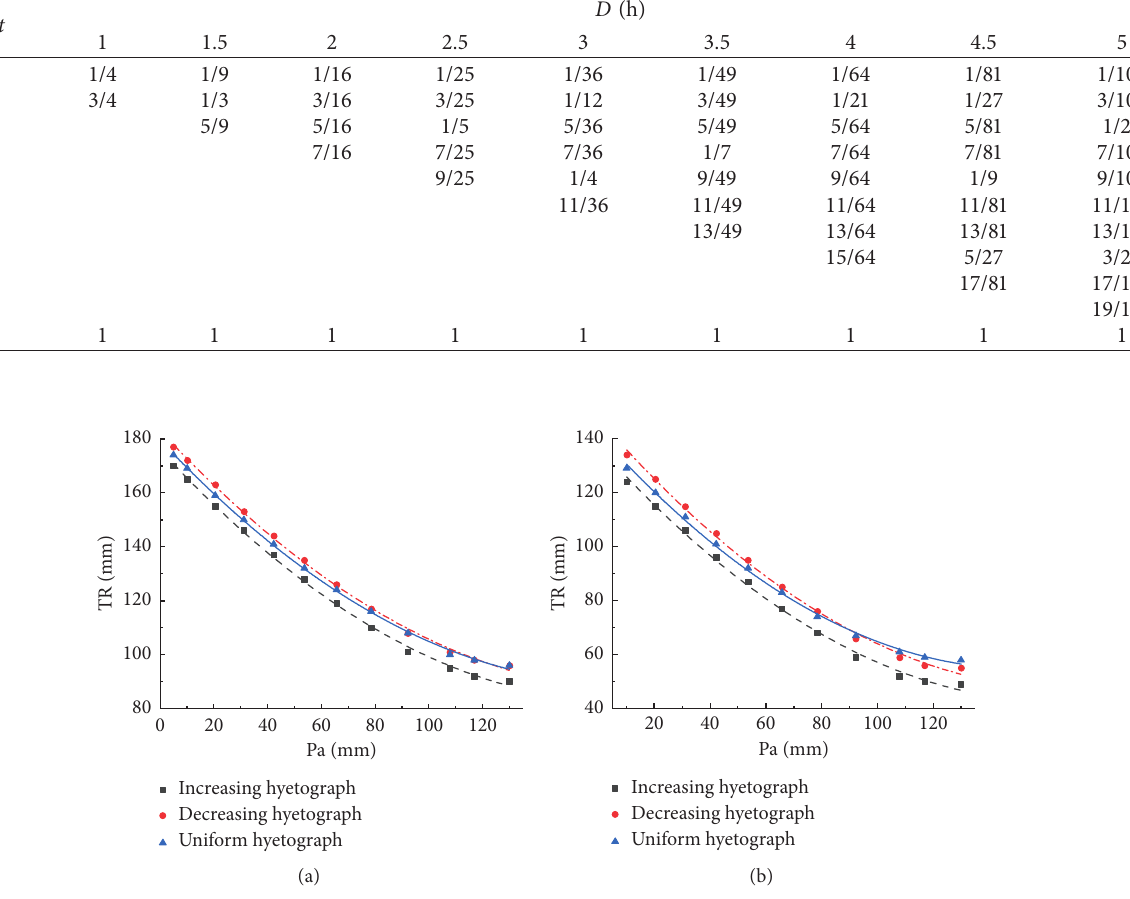
Figure 5: TR-Pa curves of (a) UH